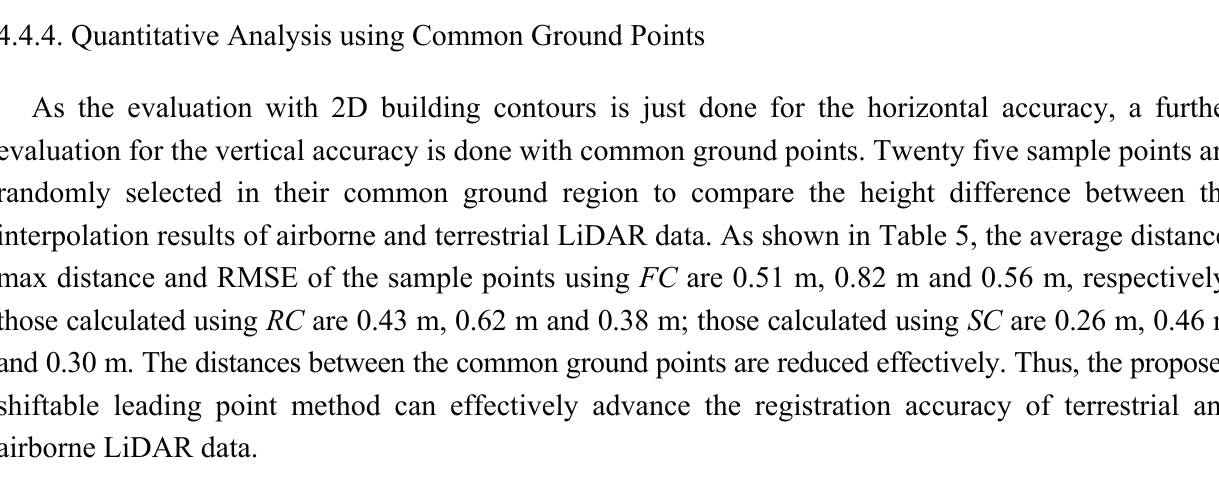
Table 5. Evaluation of the geometric precision of LiDAR data registration using common ground